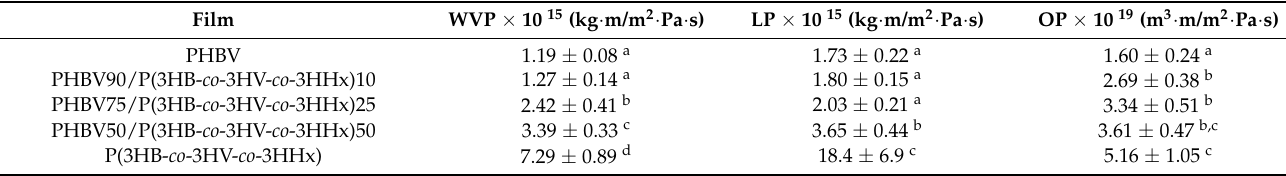
Table 4. Water vapor permeability (WVP), D -limonene permeability (LP), and oxygen permeability (OP) of the thermo- compressed films of poly(3-hydroxybutyrate- co -3-hydroxyvalerate) (PHBV), poly(3-hydroxybutyrate- co -3-hydroxyvalerate- co -3-hydroxyhexanoate) [P(3HB- co -3HV- co -3HHx)], and their